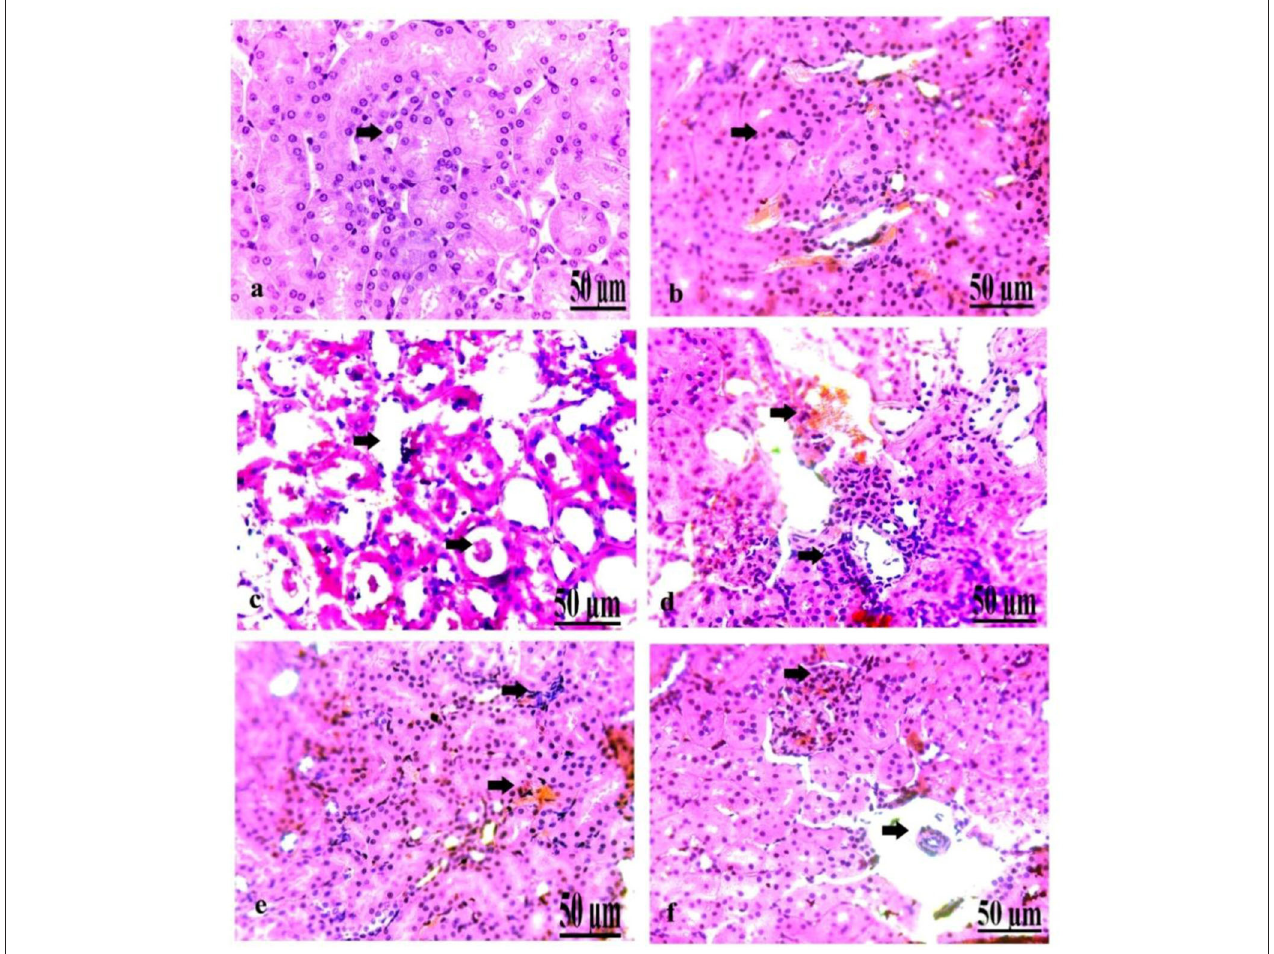
FIGURE 7 | (a–f) Photomicrograph of the kidney of the control group showing normal nephrons (a) . Photomicrograph of the kidney of the oxytocin group showed mild hemorrhage and congestion of the blood vessels, with some renal necrotic changes (b) . Photomicrograph of the kidney of group 3A (prediabetic non-treated) showing slight necrosis of renal tissues with congestion and dilatation of the blood vessels (c) . Photomicrograph of the kidney of group 3 B (diabetic non-treated) showed moderate congestion and dilatation of the interstitial blood vessels and glomeruli, besides slight necrosis of the renal tubules (d) . Photomicrograph of the kidney of group 4A (prediabetic treated) showed a moderate degree of congestion of the blood vessels, with some necrosis of the renal tissues (e) . Photomicrograph of the kidney of group 4 B (diabetic treated) showed slight congestion and hypercellularity of the glomeruli with the degree of necrosis of the renal tubules (f) (H&E., bar = 50 µ